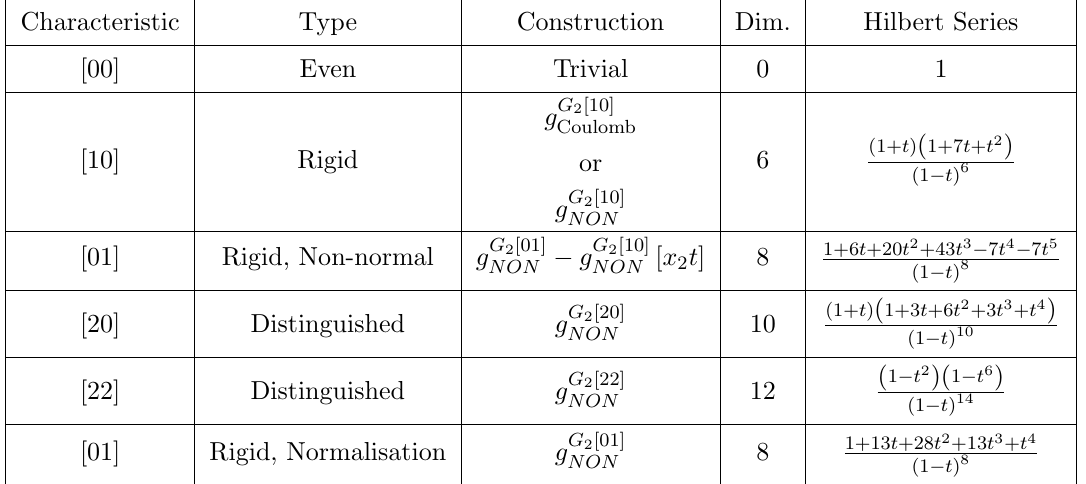
Table 3 . G 2 orbit constructions and Hilbert series. Both the non-normal 8 dimensional nilpotent orbit and its normalisation are shown.